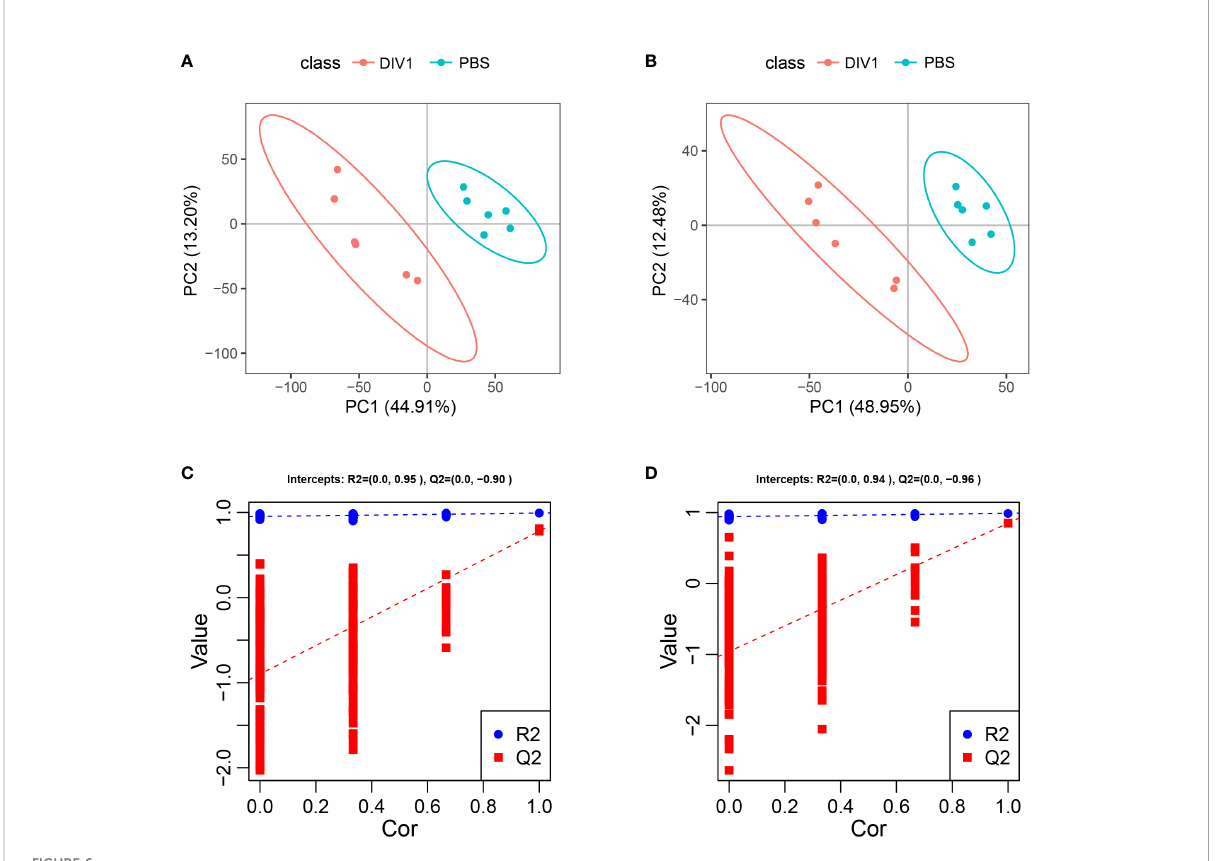
FIGURE 6 Derived PLS-DA score plots and corresponding permutation testing of PLS-DA from the LC-MS metabolite pro fi les in the intestine of M. japonicus after DIV1 infection. (A) PLS-DA score plot of positive ion mode. (B) PLS-DA score plot of negative ion mode. (C) Permutation testing of positive ion mode. (D) Permutation testing of negative ion